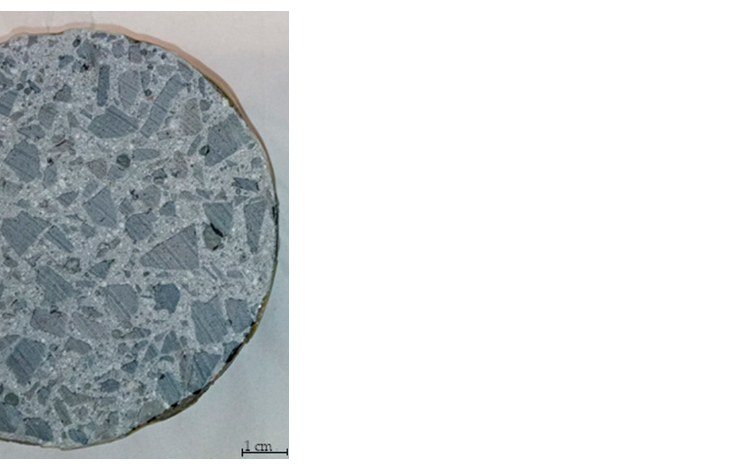
Figure 4. Mechanical properties of alkali-activated concretes after 28 and 180 days: ( a ) compressive strength (f c ); ( b ) splitting tensile strength (f t ).